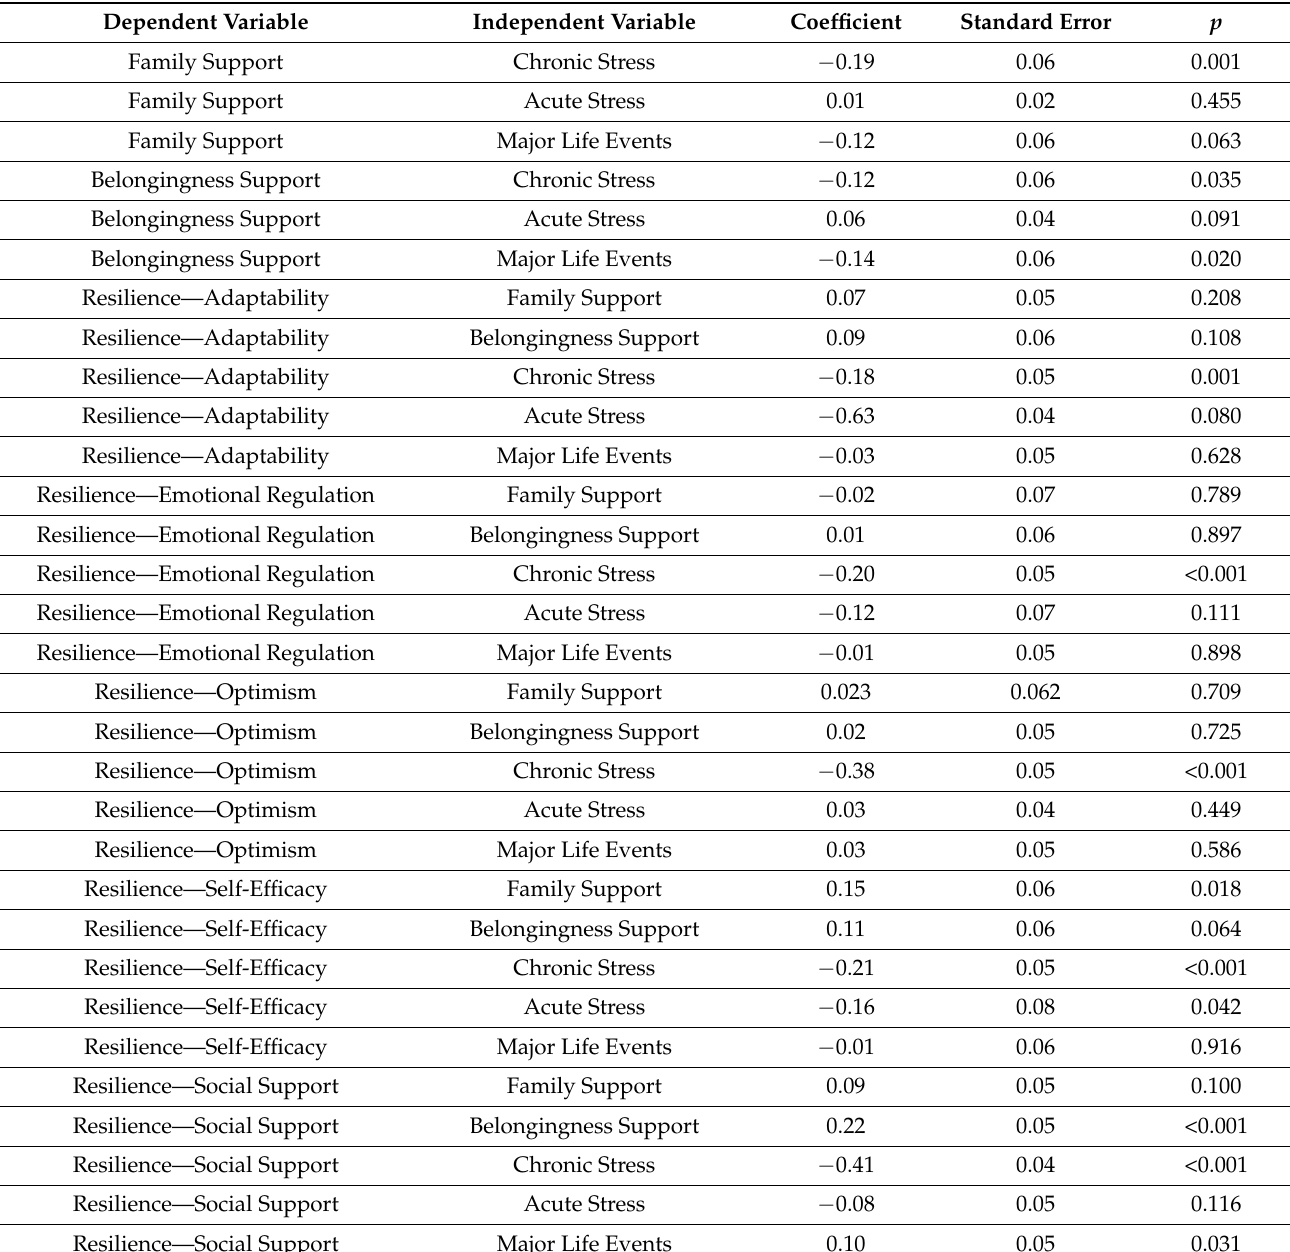
Table 2. Standardized path coefficients, standard errors, and p -values for the fitted mediation model.